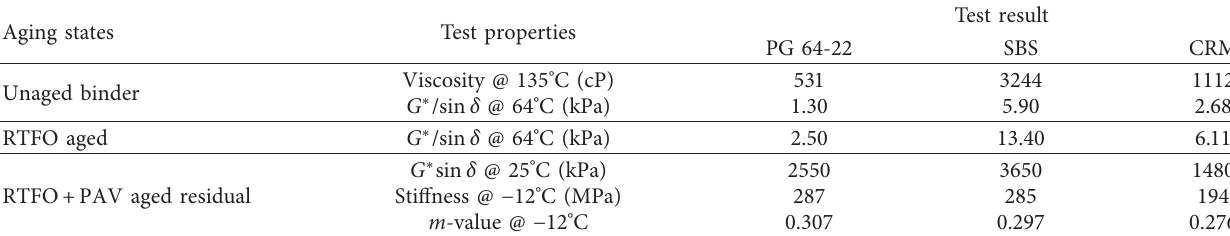
Table 1: Properties of asphalt binder.